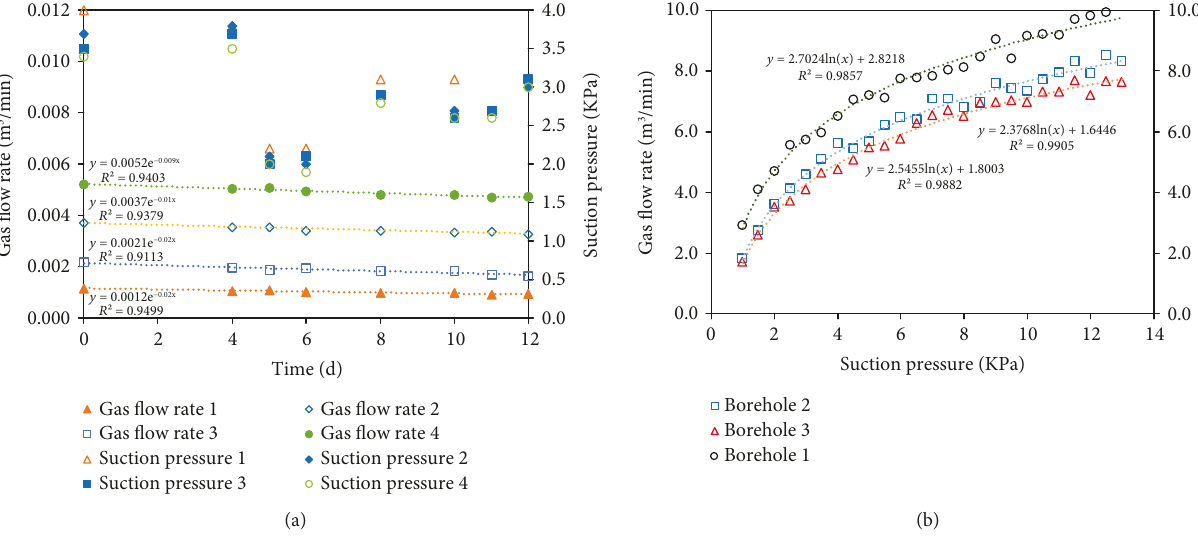
Figure 3: Relations between the gas fl ow rate from a borehole versus suction pressure in the elastic deformation area and the plastic deformation area. (a) Elastic deformation area. (b) Plastic deformation